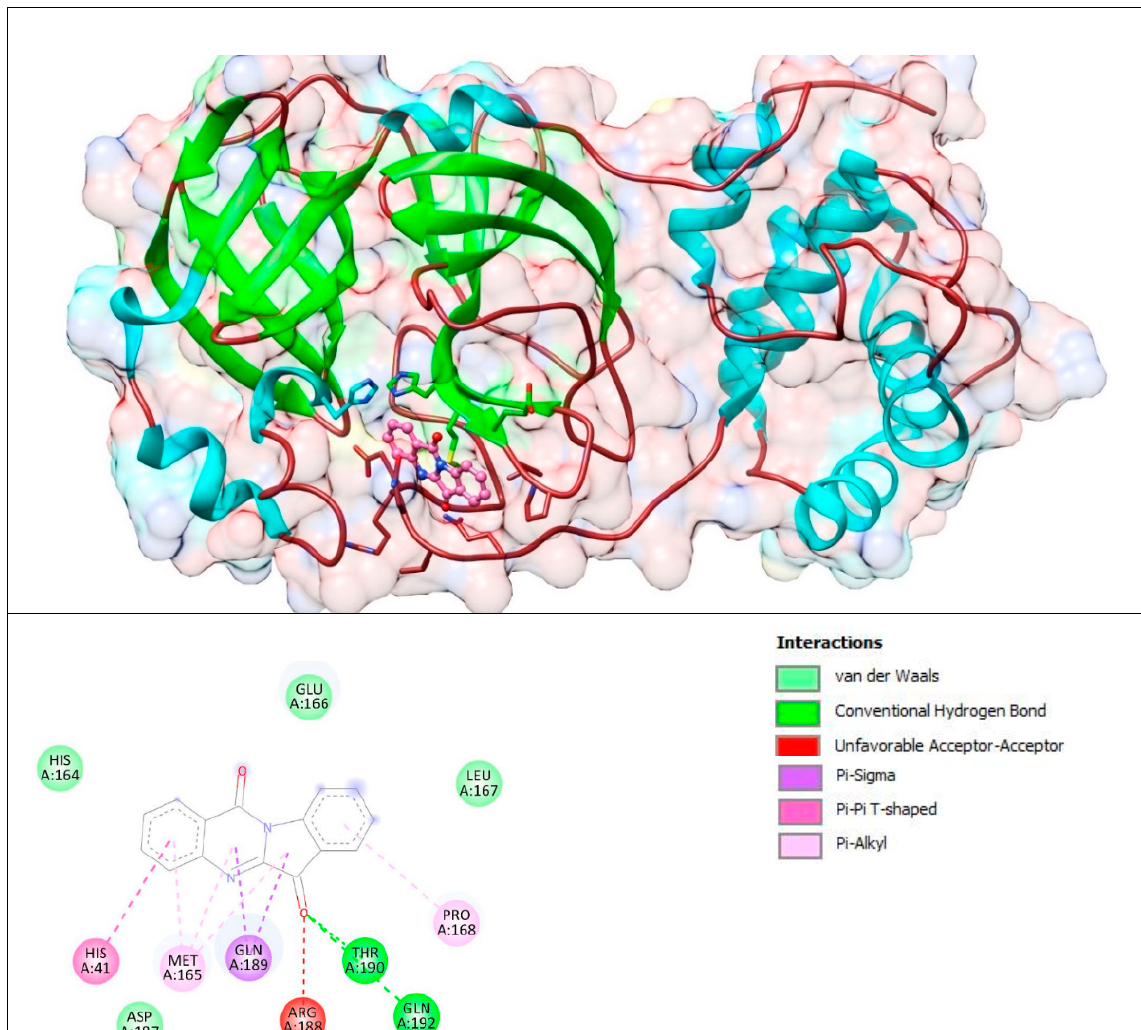
Figure 17. Complex of Mpro with T8H (tryptanthrin). The upper panel shows a 3D model of Mpro with a binding site (cavity) on its surface T8H. The lower panel shows the binding mode of T8H with the amino acid residues of M pro. Figure 17 was created with UCSF Chimera ( upper panel ) and BIOVIA Discovery Studio Visualiser ( lower panel ) and shows the best docking pose of T8H on Mpro. We can also see where T8H is placed on the Mpro surface and a general view of the complex of Mpro (green–cyan–brown) with T8H (pink). The secondary structure of the protease behind the molecular surface (created with 90% transparency for better presentation of the molecule) is also shown. Table 4. Binding energy and association constant of PAA, PAA and T8H and T8H-TSC for Mpro. PAA Binding energy